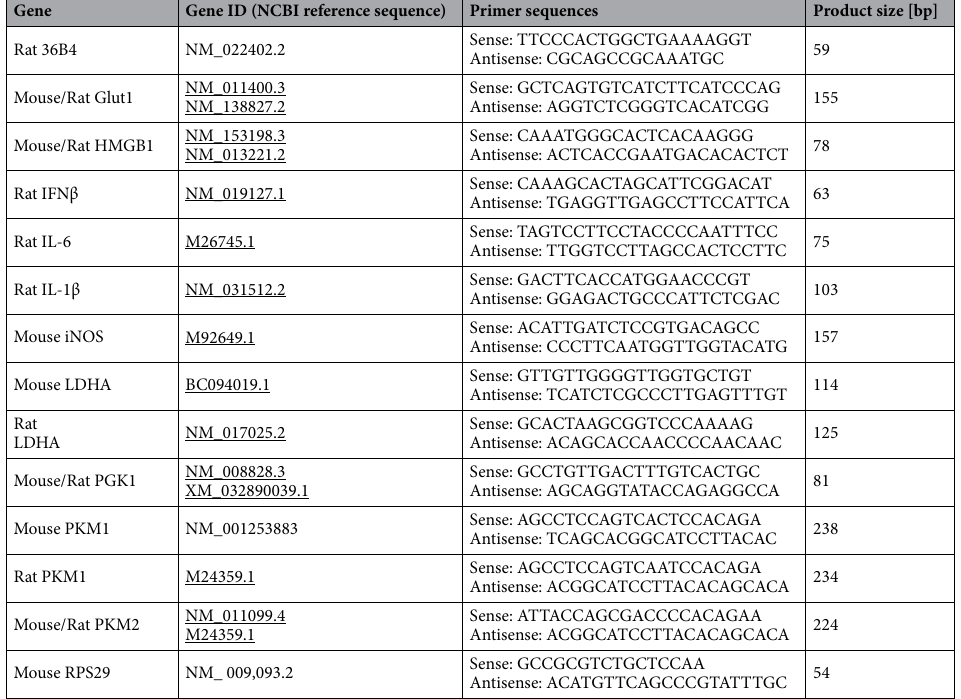
Table 1. Gene identifiers and primer sequences used in quantitative